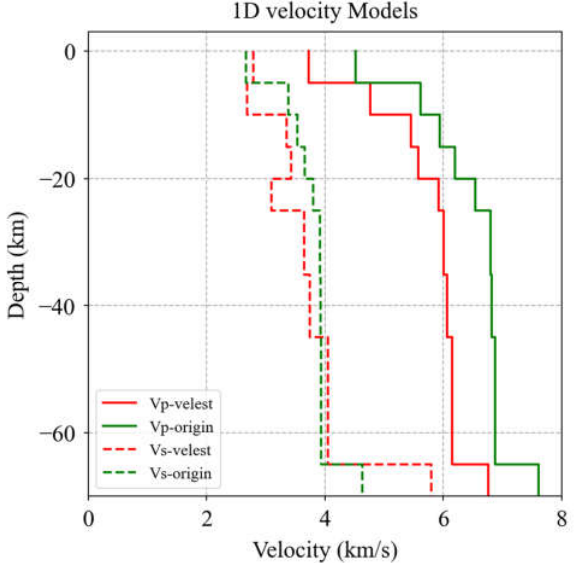
Figure 3. Initial 1-D velocity model (green line) and the optimized 1-D velocity model (red line) based on the VELEST method. on the VELEST